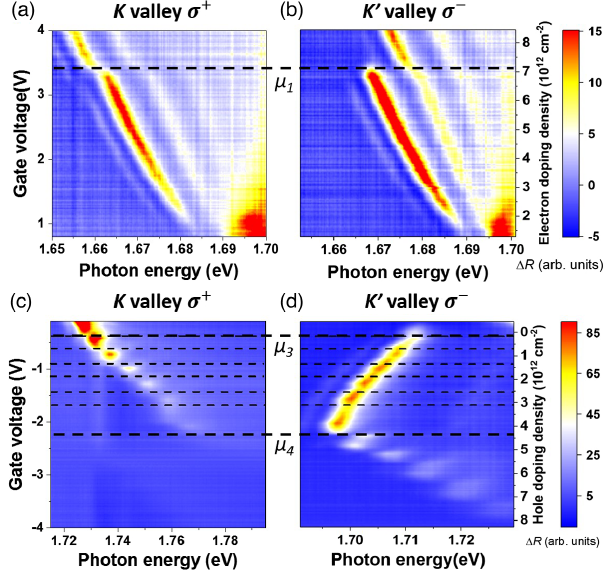
FIG. 3. Magnetoreflectance spectra modified by inter-LL transitions. (a),(b) Enlarged color plots of the helicity- resolved optical reflectance spectra for K (a) and K 0 (b) valleys in Figs. 2(a) and 2(b), in the highly n -doped region. (c),(d) Enlarged color plots of Figs. 2(a) and 2(b) in the p -doped